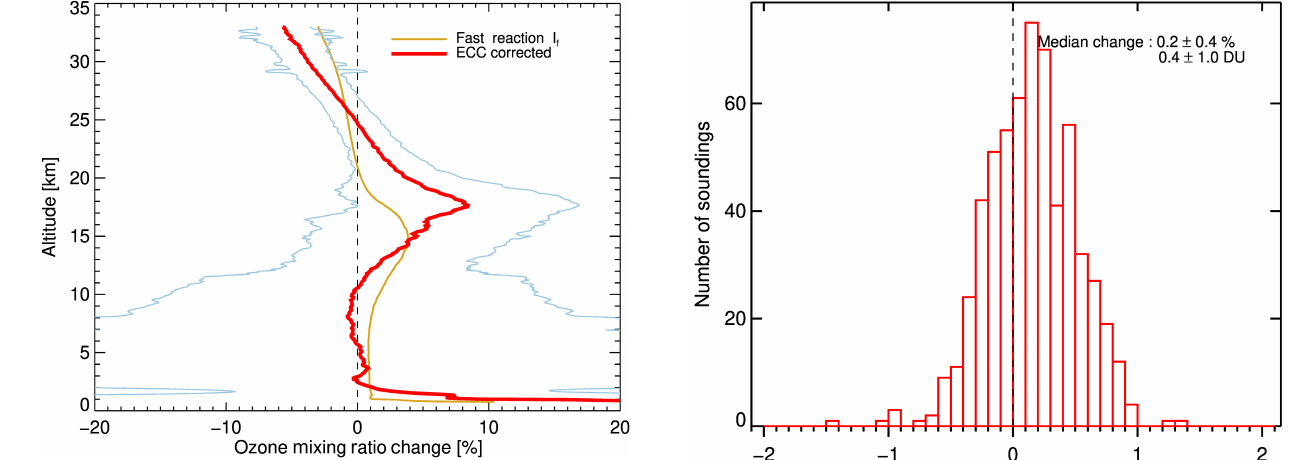
Figure 11. Median difference between corrected and originally re- ported ozone mixing ratio for 577 ozonesondes launched at Costa Rica. Thin orange line: fast-reaction contribution only. Thick red line: complete correction algorithm including time lag correction. The thin blue lines: 1 standard deviation around the complete cor- rection algorithm.